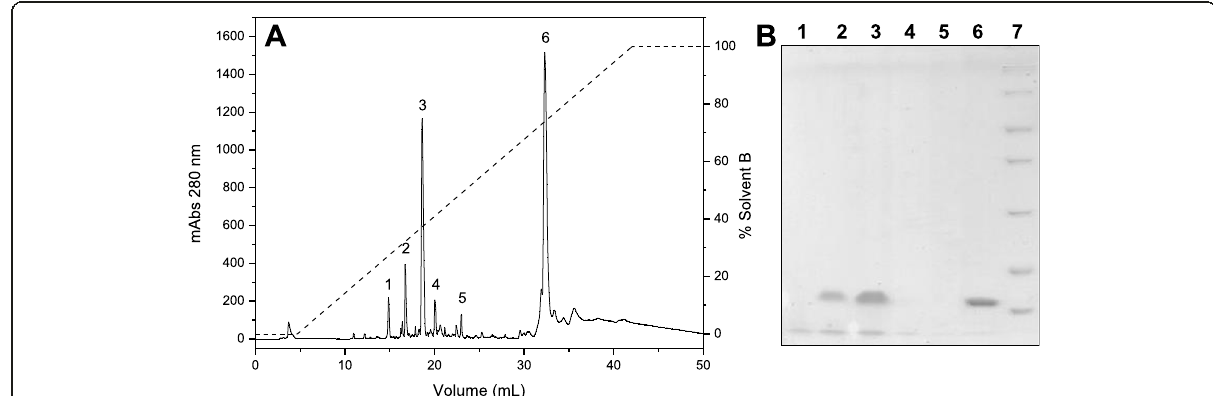
Fig. 3 a Chromatographic profile of fraction D3 on a C18 reverse phase column. Elution was performed using a RP-HPLC system at a flow rate of 0.5 mL/minute with a linear concentration gradient of 0-100 % solvent B (70 % acetonitrile and 0.1 % TFA) in ten column volumes. b 12 % SDS-PAGE. Lanes: 1 – fraction 1; 2 – fraction 2; 3 – fraction 3; 4 – fraction 4; 5 – fraction 5; 6 – fraction 6; 7 – molecular mass standard (116,